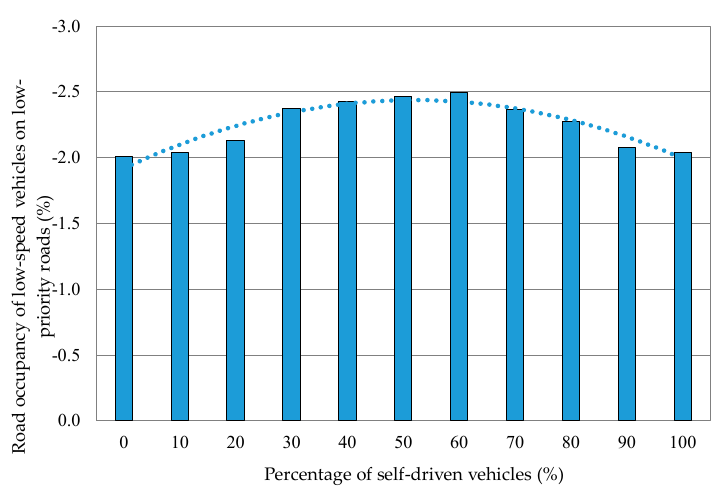
Figure 21. Variation in the road occupancy of low-speed vehicles on low-priority roads when the percentage of self-driven vehicles was varied. The average driving speed was the average for all the vehicles that came in.